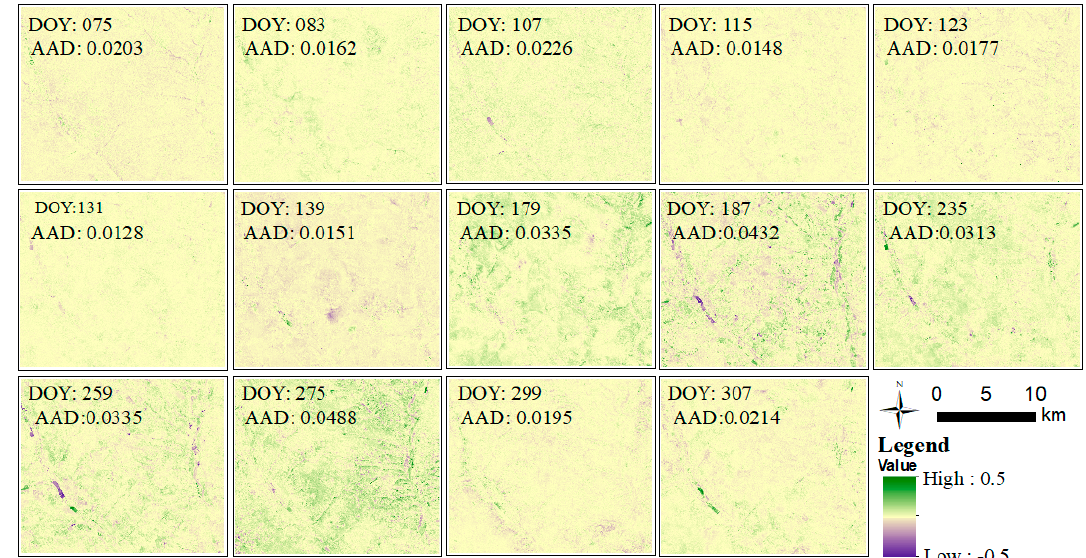
Figure 6. Difference between NDVI images by using the NDVI calculated from Spatial and Temporal Adaptive Reflectance Fusion Model (STARFM) blended images minus the NDVI calculated from Enhanced STARFM (ESTRAFM) blended images.